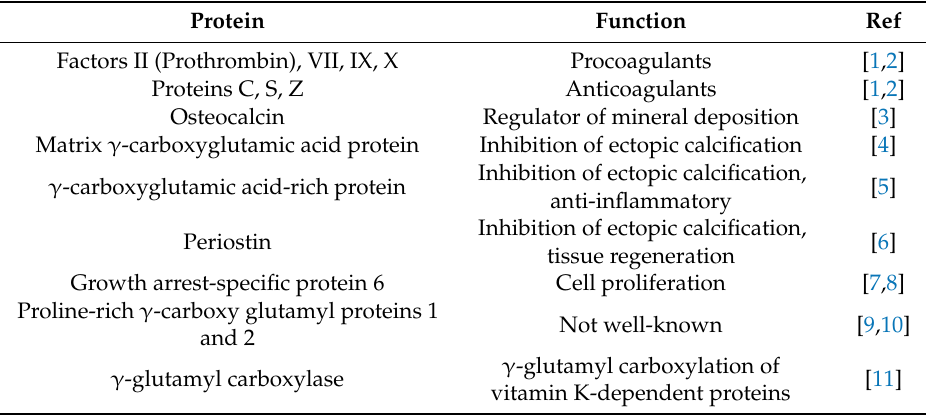
Table 1. Vitamin K-dependent